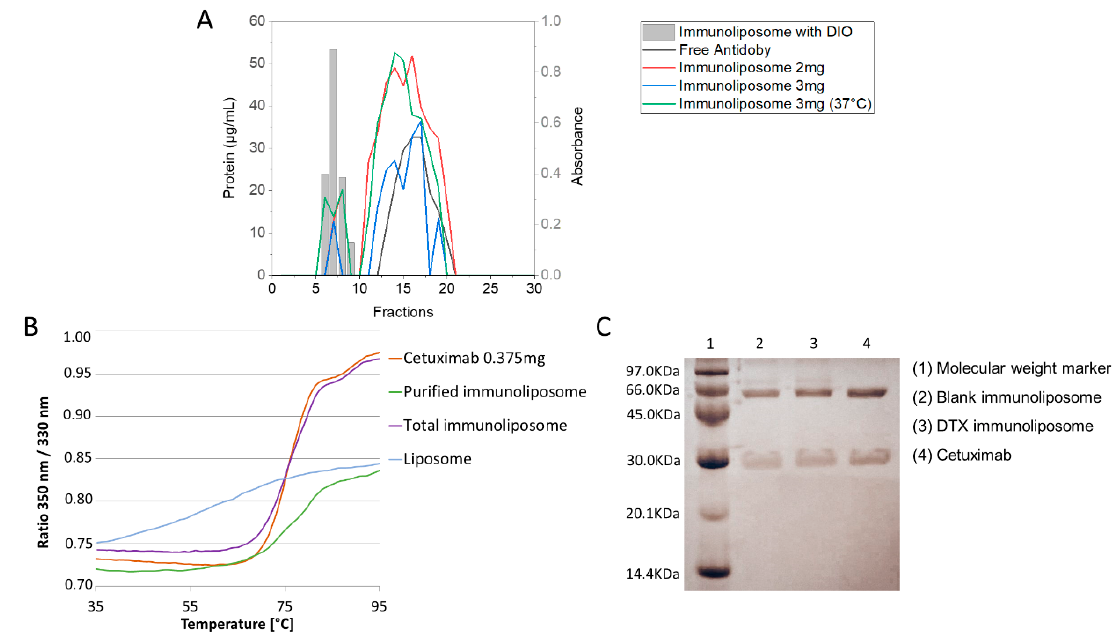
Figure 4. Liposome elution profile with DIO fluorophore, free antibody, docetaxel immunoliposome with 2 mg antibody, docetaxel immunoliposome with 3 mg antibody and docetaxel immunoli- posome with 3 mg antibody (Incubation 37 ◦ C) by size exclusion chromatography on Sepharose CL-4B ( A ) Graph of thermophoresis of cetuximab antibody, total immunoliposome, purified im- munoliposome and liposome ( B ) SDS-Page gel electrophoresis for free cetuximab and blank and docetaxel-containing immunoliposomes ( C